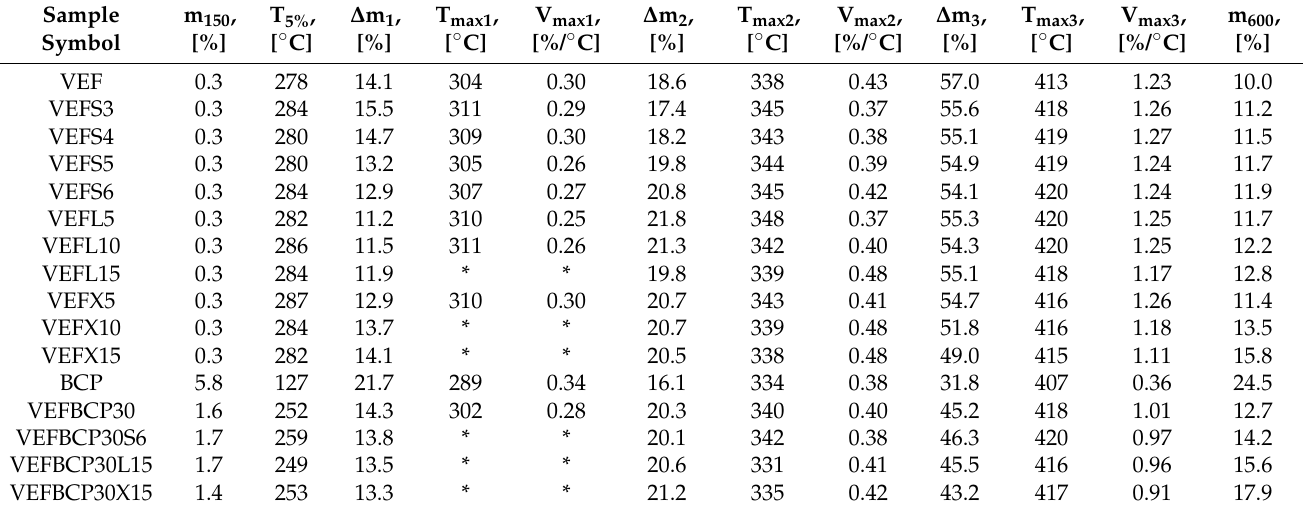
Table 5. Results of the thermogravimetric analysis under nitrogen for the VEF